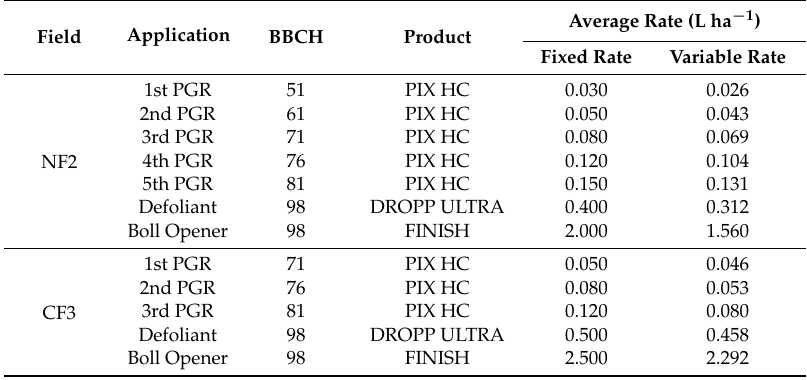
Table 6. Input savings with variable rate application of plant growth regulators and fruit ripener in cotton variety TMG 81 WS in conventional and narrow row